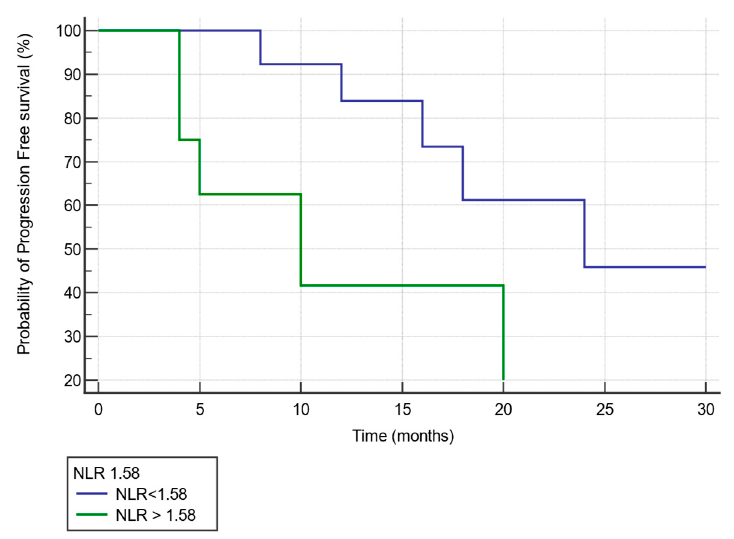
Figure 5. Kaplan–Meier survival curves comparing patients according to NLR value after three cycles of NACT. Patients with a NLR > 1.58 (green line) in comparison to patients with a NLR < 1.58 (blue line) after three cycles of NACT showed a significantly lower progression-free survival (median progression free survival: 10 months versus 24 months, respectively).